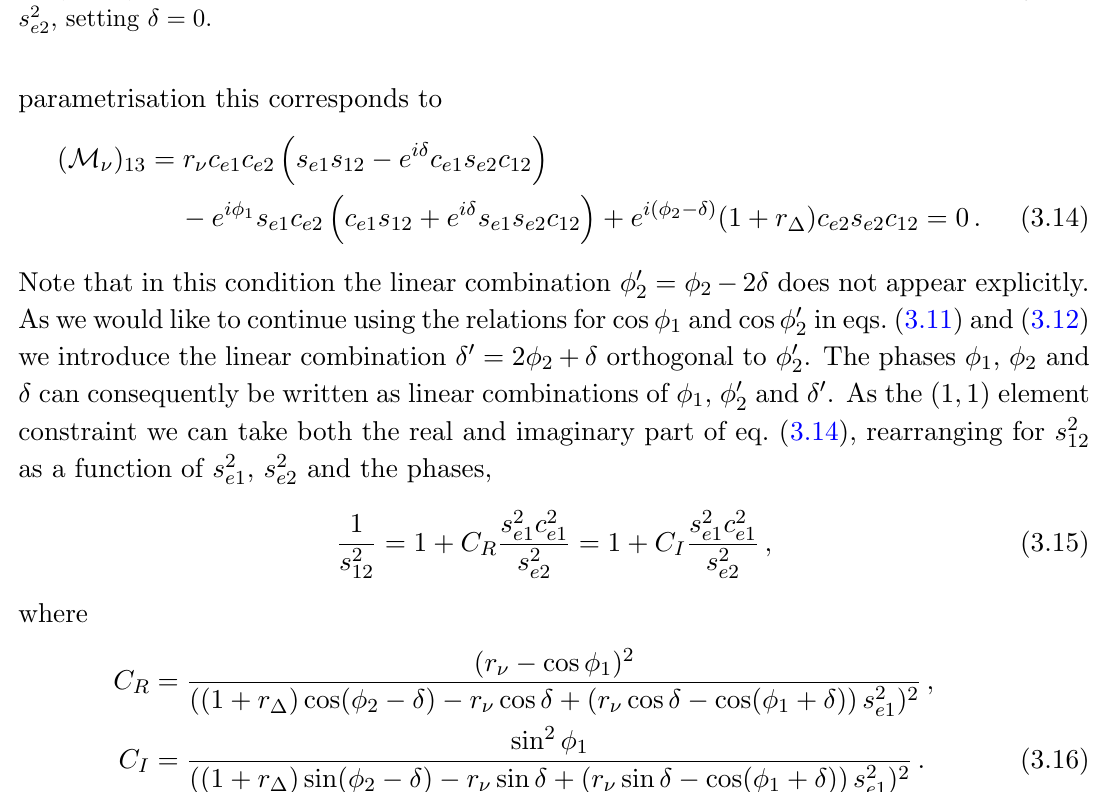
(cid:30) 0 as a function of the active-sterile 2 (cid:0) and r (cid:23) = (1 + r (cid:23) + r (cid:1) ) 1 as a function of s 2 and 12 e 1